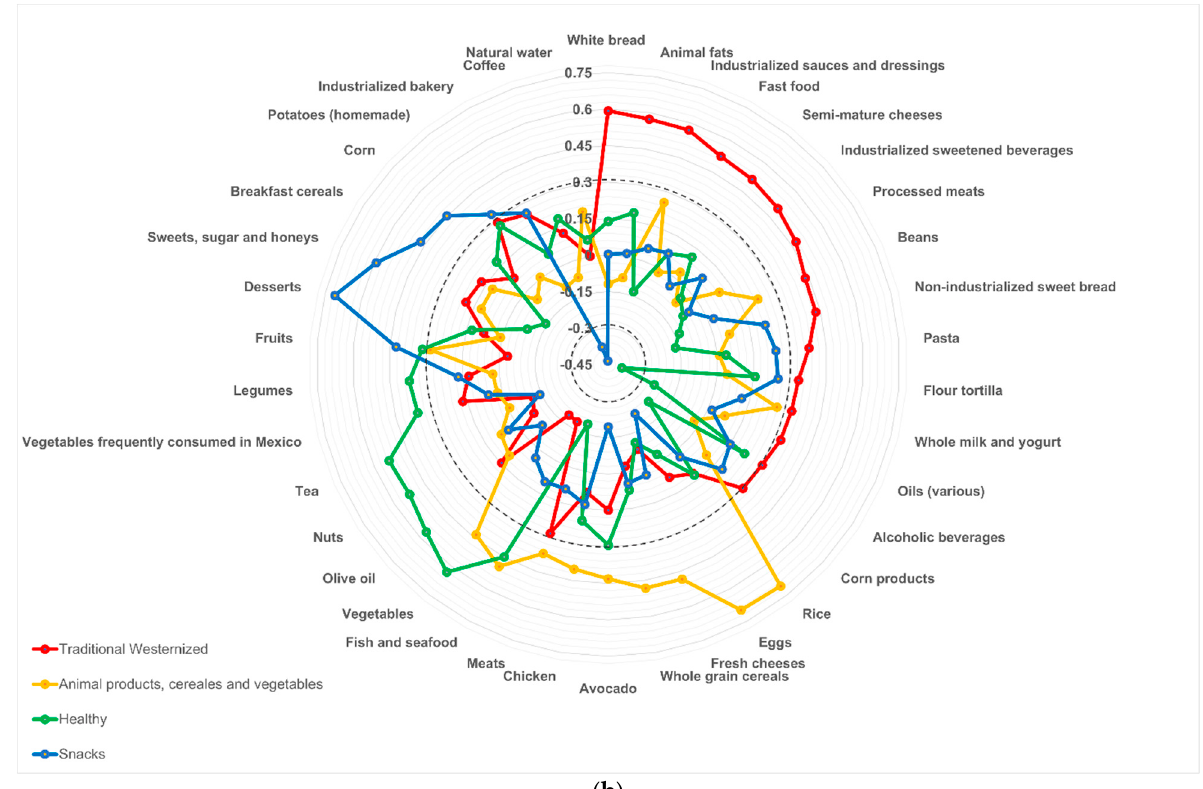
Figure 2. Dietary patterns drawn from participants with and without abdominal obesity. This figure shows the dietary patterns (DPs) identified in participants with abdominal obesity ( a ), and those without abdominal obesity ( b ). The numbers expressed are the factor loads obtained by principal component analysis. DPs are only made up of food groups with a factor load equal to or greater than 0.3 or close to 0.3 (positive or negative). The dotted line indicates the factorial load equal to 0.3 to improve the interpretation of the graph. If a food group had a factor loading ≥ 0.3 on more than one DP, this food group was considered part of more than one DP. The food groups that make up the DP named “Traditional Westernized” are in red. The food groups that make up the DP named “Animal products and cereals” or “Animal products, cereals, and vegetables” are drawn in yellow. The green color shows the food groups that make up the DP named “Healthy”, and the blue color shows the food groups that make up the DP named “Snacks and fast food” or “Snacks” in the abdominal obesity group and the non-abdominal obesity, respectively.